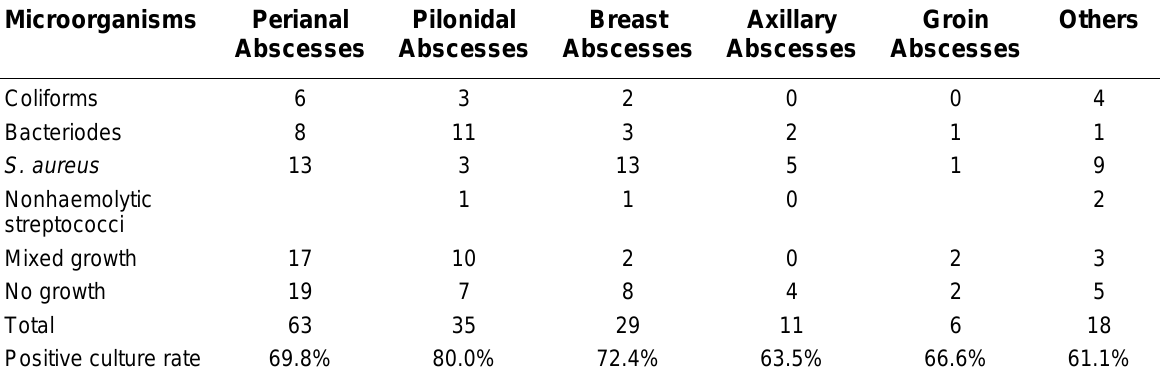
Frequency of Different Microorganisms Grown from Each